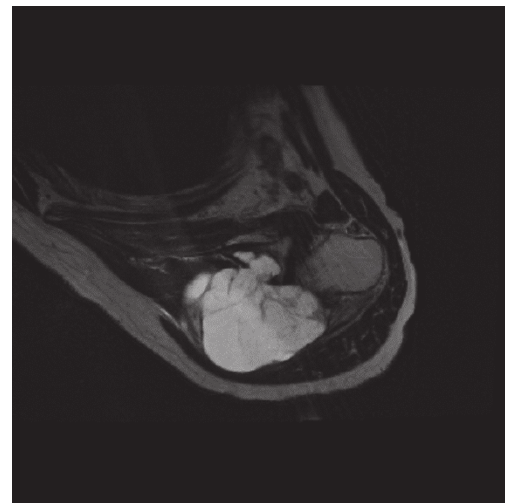
Figure 2: STIR and T2-weighted transverse MRI. Observe the huge cystic-like hyperintense mass growing inside the deltoid muscle and invading the scapula. The mass contains some septations but there is no apparent solid